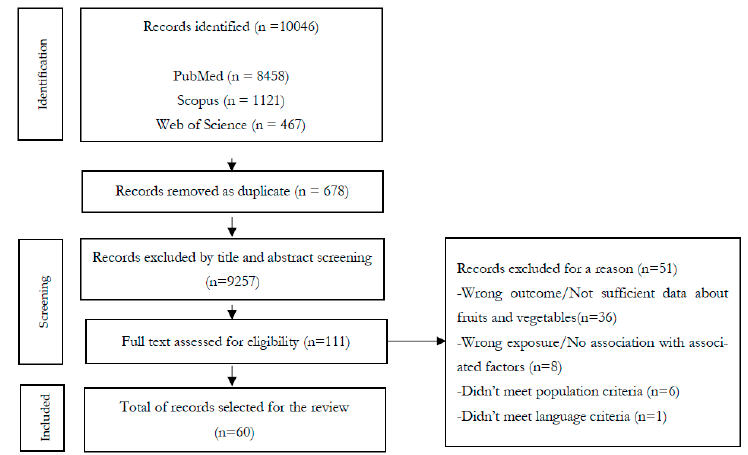
Figure 1. Flow chart: process applied to select the included studies.